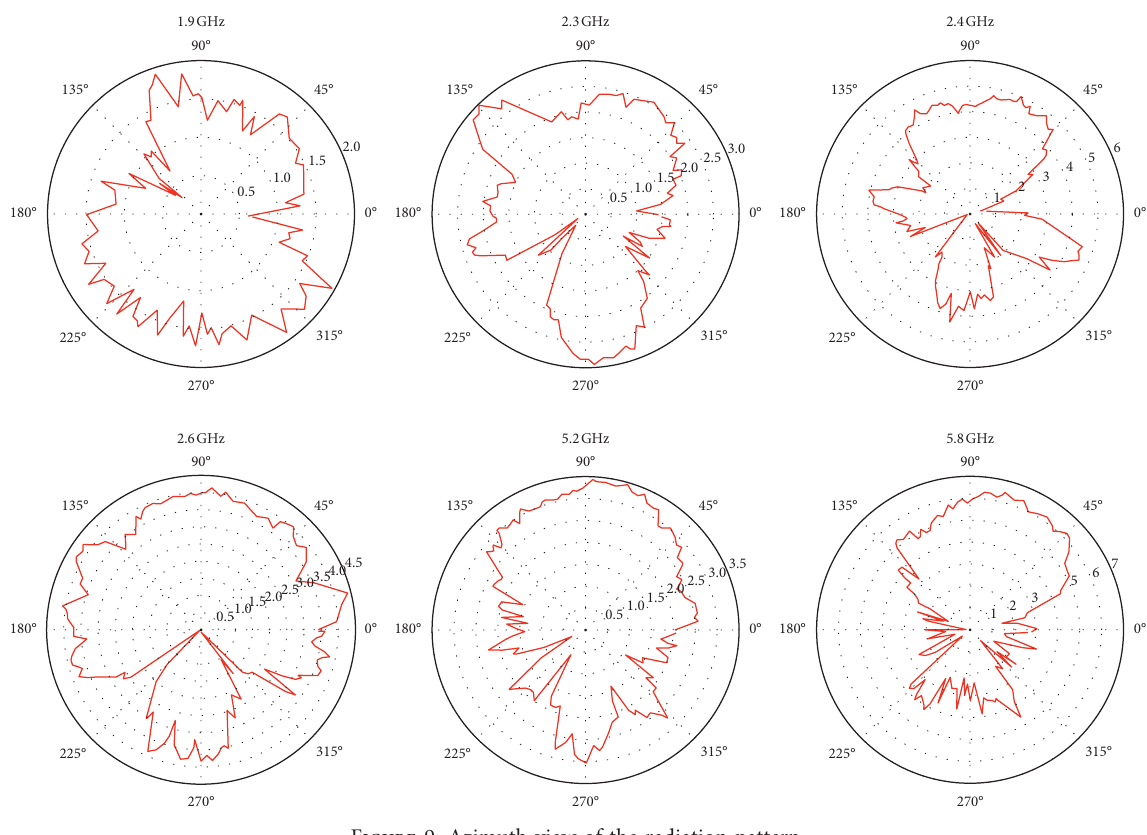
Figure 9: Azimuth view of the radiation pattern.